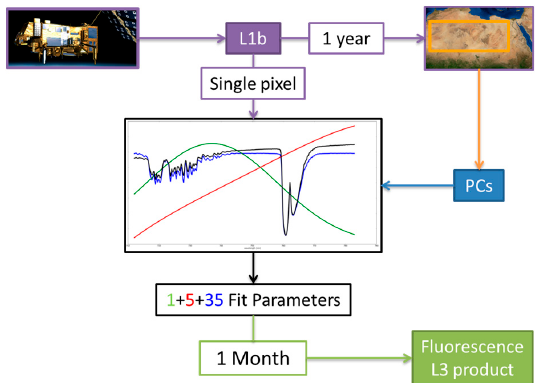
Figure 1. Flow diagram of the GOME-2 SiF retrieval algorithm. One year of fluorescence-free reference pixels is selected from the GOME-2 Level-1b data as input for the Principal Component (PC) algorithm. The 35 most significant PCs are used to build a cost function and minimization of the cost function for each pixel yields 41 fit parameters (one fluorescence parameter, five surface albedo polynomial coefficients and 35 PC coefficients). The peak fluorescence at 737 nm is then averaged monthly in 0.5° by 0.5° latitude–longitude grid cells resulting in the final Level-3 product.